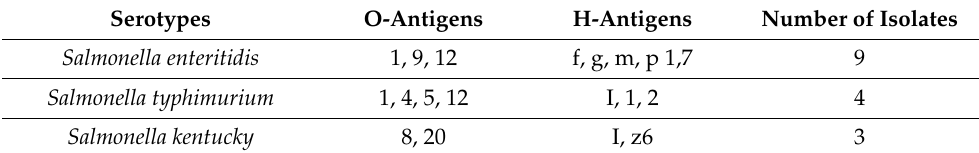
Table 3. Somatic and flagellar antigen distribution within the 16 isolated Salmonella strains. Serotypes O-Antigens H-Antigens Number of Isolates